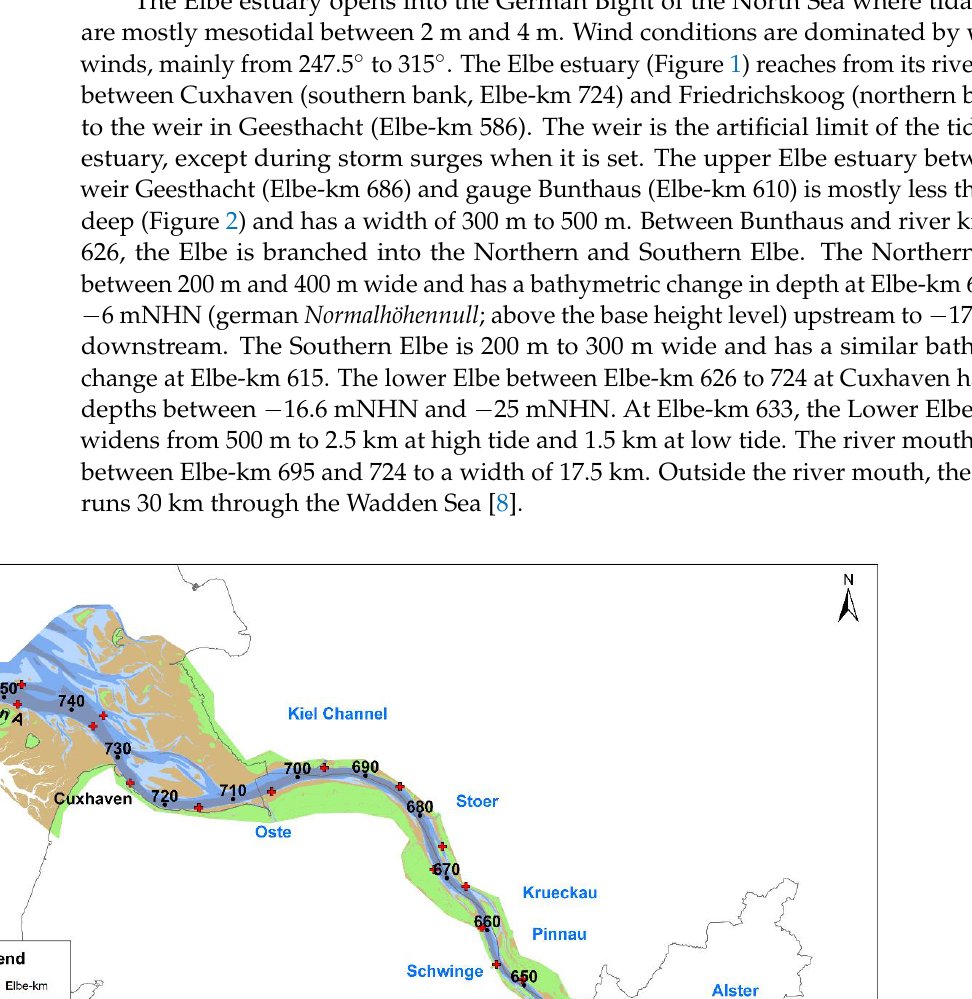
Figure 2. Fairway bathymetry averaged over 1 km representative for the investigation period, and mean sea level (MSL) for river discharges of 350 m 3 /s and 1500 m 3 /s. Major tidal wave reflection occurs in the Elbe estuary mainly at the abrupt bathymet- ric changes in the Southern Elbe at river kilometre 615, in the Northern Elbe around kilo- metre 620 and at the weir in Geesthacht at Elbe-km 586. The cross-sectional constrictions are partial reflectors and the weir is a total reflector. The maximal tidal ranges are meas- ured at the partial reflectors around river kilometre 615 in the Southern Elbe. Minimal tidal ranges are between Elbe-km 675 and 695. Upstream the cross-sectional constrictions, the tidal range decreases, as a result of increased bottom friction, as the water depth is lower and because of the increased damping influence of the river discharge in this area.